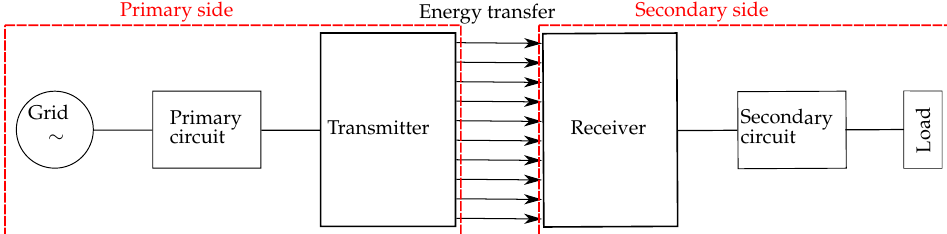
Figure 1. Wireless power transfer